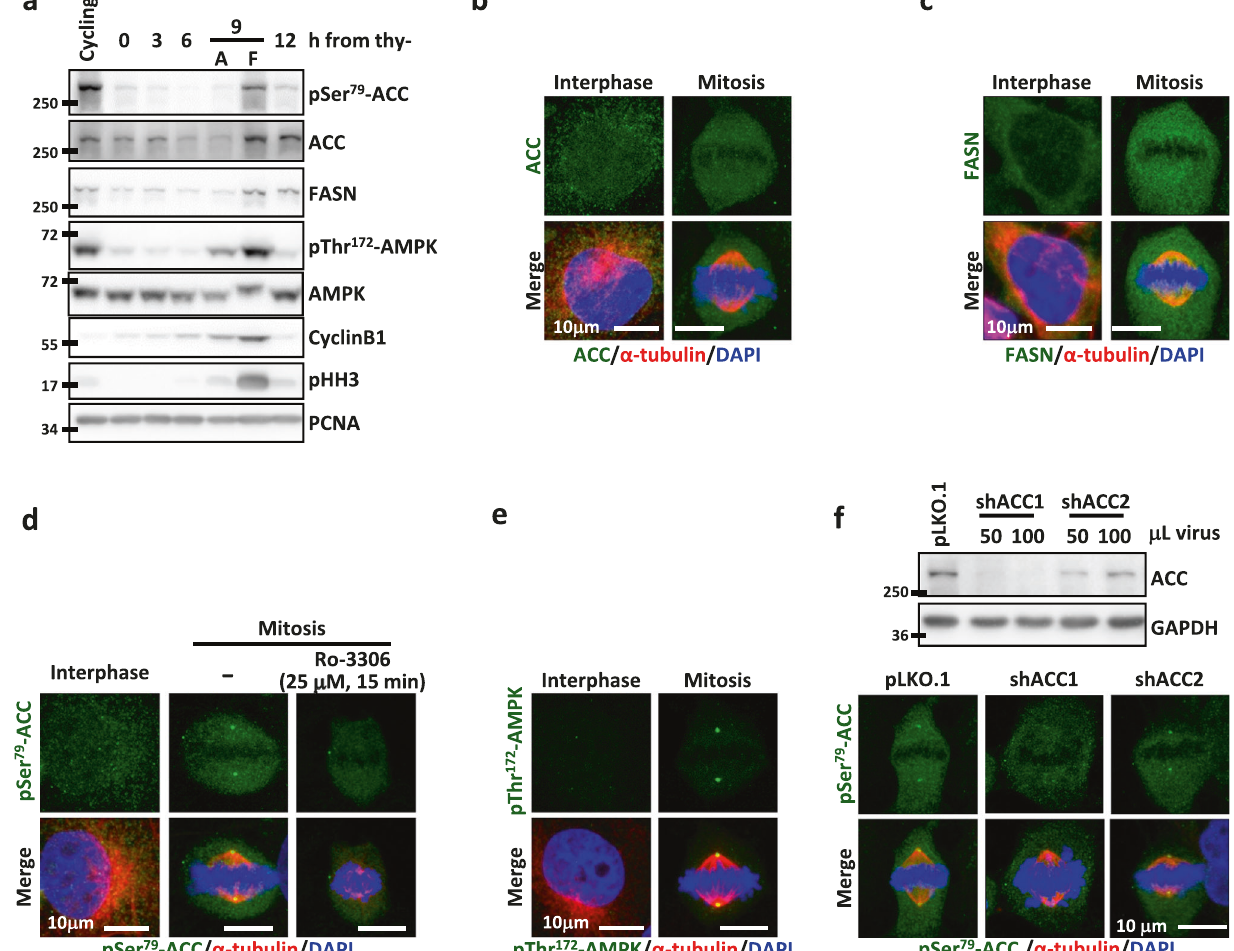
Fig. 1 The expression and cellular distribution of ACC and FASN. ACC is phosphorylated during mitosis and localizes to the spindle pole (SP). a Level of the indicated proteins at each cell cycle stage. The cell cycle of CGL2 cells was enriched at each stage by double-thymidine block and release. The stages of attached G2 interphase cells (A) and fl oating mitotic cells (F) collected at 9 h after thymidine release (thy-) were con fi rmed by the expression of the G2/M markers Cyclin B1 and pHH3. b , c Subcellular localization of ACC ( b ) and FASN ( c ) in interphase and mitotic CGL2 cells. Cells were fi xed and immunostained for ACC or FASN (green) as described and co-stained for α -tubulin (red) and DAPI (blue). d Subcellular localization of pSer 79 -ACC in interphase cells, untreated mitotic cells and mitotic cells treated with Ro-3306 as indicated. Cells were stained for pSer 79 -ACC (green), α -tubulin (red), and DAPI (blue). e Subcellular localization of pThr 172 -AMPK in interphase and mitotic cells. Cells were stained for pThr 172 -AMPK (green), α -tubulin (red), and DAPI (blue). f , top: Western blots show the ef fi ciency of ACC depletion by shRNAs. Cells were transduced with shRNA targeting either ACC1 (shACC1) or ACC2 (shACC2) and the lysates were probed with an ACC antibody recognizing both forms. Cells transduced with the empty vector pLKO.1 were used as the control. The volumes of the shRNA- containing virions are indicated. f , bottom: Subcellular localization of pSer 79 -ACC in mitotic cells after transduction with control vector (pLKO.1), shACC1 or shACC2. Cells were stained for pSer 79 -ACC (green), α -tubulin (red), and DAPI